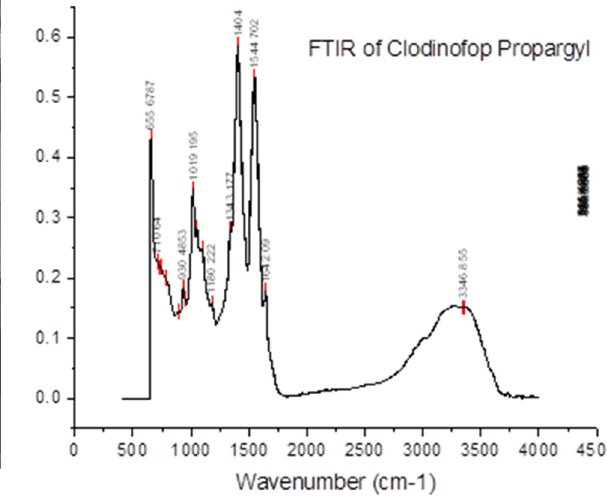
Figure 1: SEM micrograph of chitosan - based clodinofop propargyl nanoparticles.